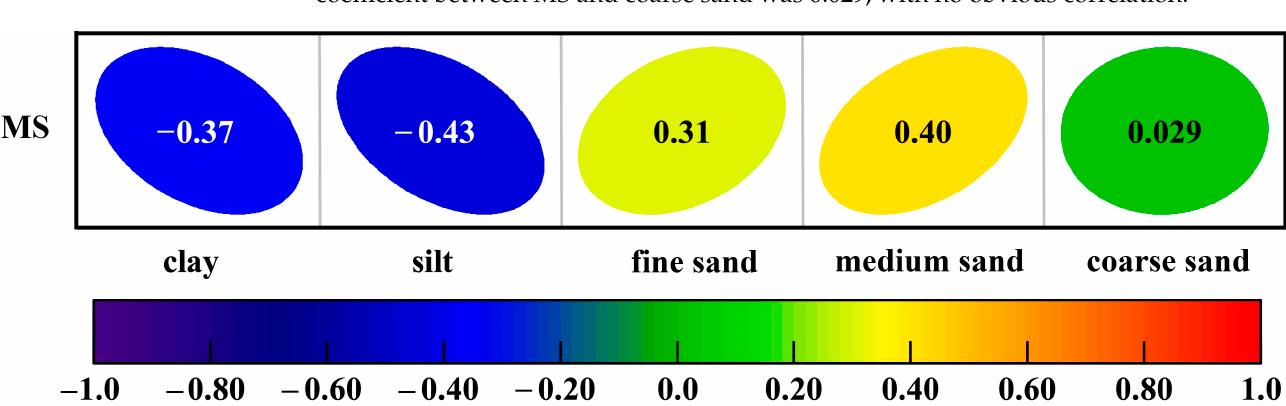
Figure 4. Comparison diagram between MS and grain size of the SHBZK-1 core. ( a ) MS curve; ( b ) silt (4~8 𝚽 ) curve; ( c ) sand (1~4 𝚽 ) curve; ( d ) coarse sand ( − 1~1 𝚽 ) curve.